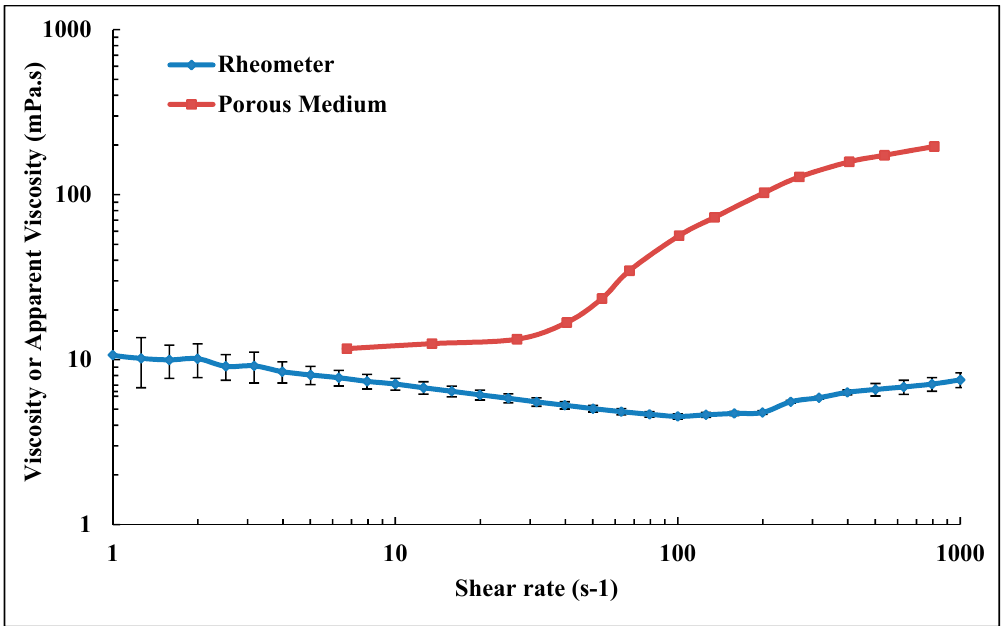
Figure 5. Viscosity of pre-filtered Solution A (Concentration = 500 ppm, MW = 18 MDa) measured in porous medium and in bulk.